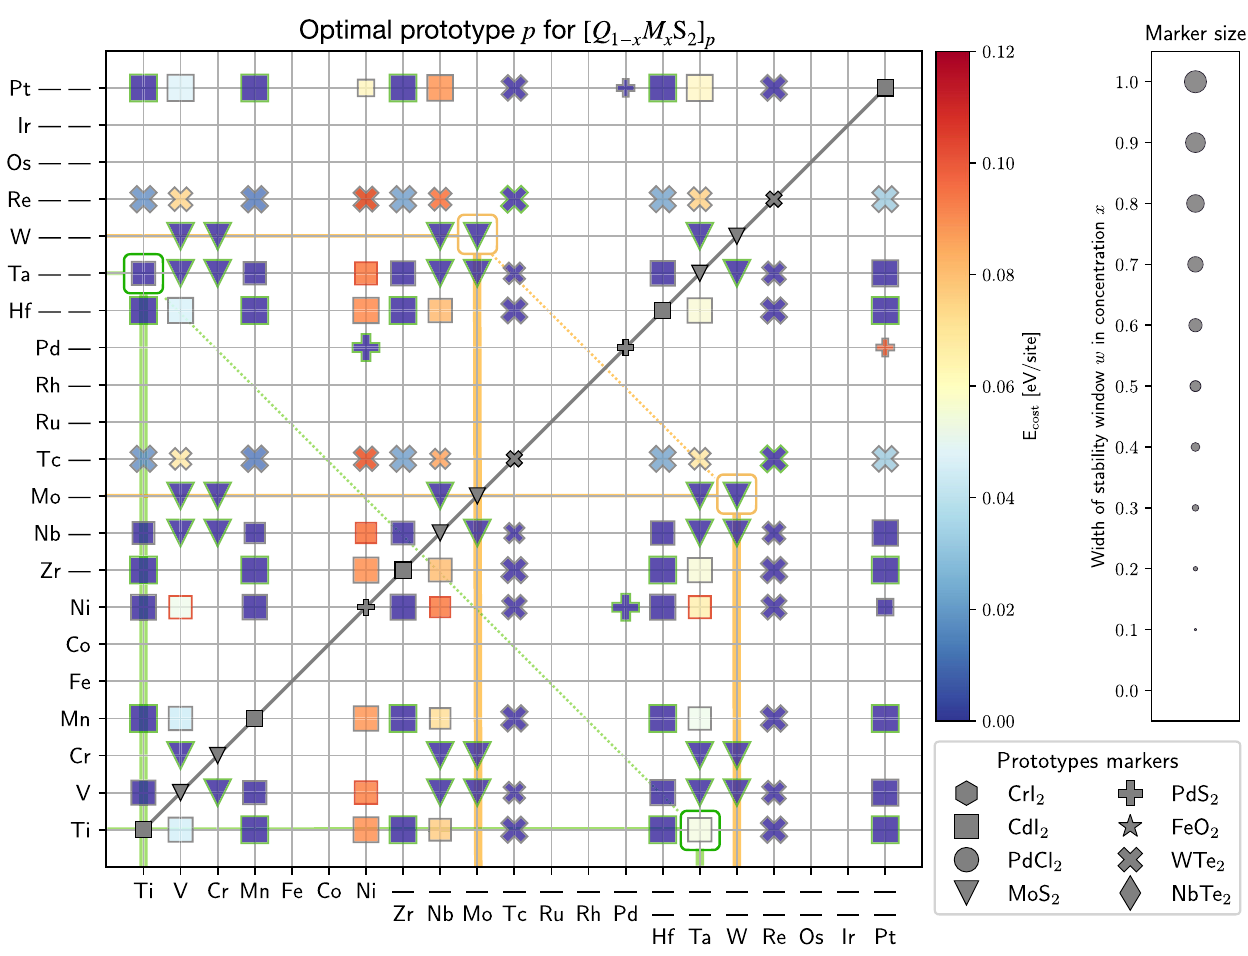
Fig. 4 Optimal prototype host. Optimal prototype for TM pairs. The colourcode shows the energy cost at each end of the window, in eV/site. The scale is reported in the fi rst colorbar on the right. The energy cost of the mark refers to the end of the metastability window closer to the M S 2 indexed by the x -axis. The size of the marker encodes the metastability window size, as reported by the legend on the far right. The edge colour of each marker indicates whether the optimal prototype is the ground state of both (green), one (grey) or neither (red) the pristine TMDs comprising the ( M : Q )S 2 mixture. Marker-prototype correspondence is reported in the legend at the bottom right. Markers on the diagonal show the GS prototype of the corresponding metal disul fi de. Green and orange lines highlight the entries relative to the examples shown in Fig. 3b, c and discussed in the main text. For a version without examples highlights and one without thresholds see Supplementary Fig. 13a, b.